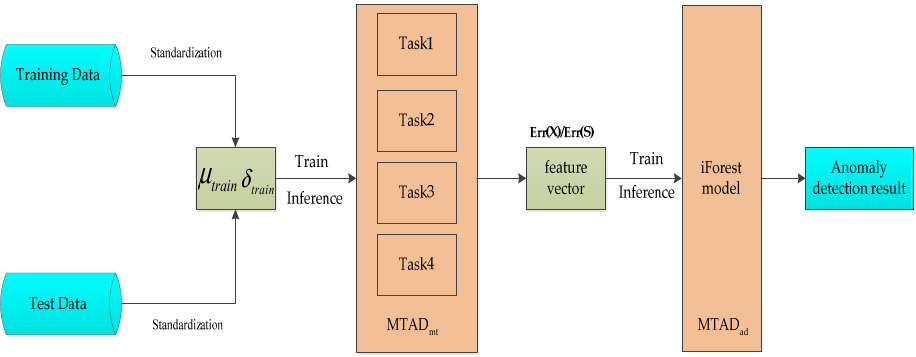
Figure 3. Overall process of the proposed MTAD method.